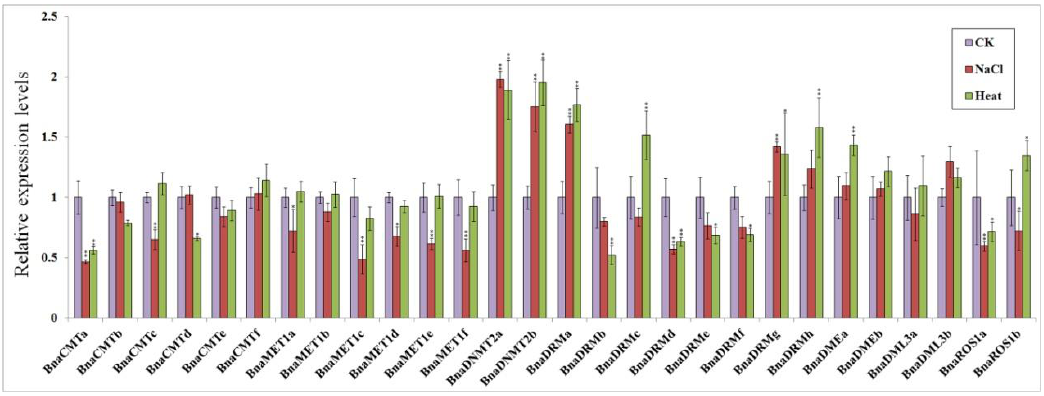
Figure 6. Expression patterns of target genes in response to salt and high temperature stress conditions. Three replicates were performed for the analysis of each condition: untreated control (purple), 24 h 300 mM NaCl stress (red), and 24 h 50 ◦ C heat stress (green). Transcript levels were analyzed